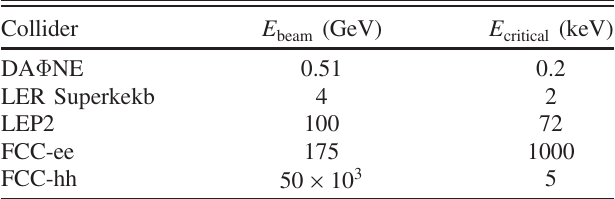
TABLE II. Critical energies from arc dipoles for different e þ e − colliders and the proton-proton collider FCC-hh.